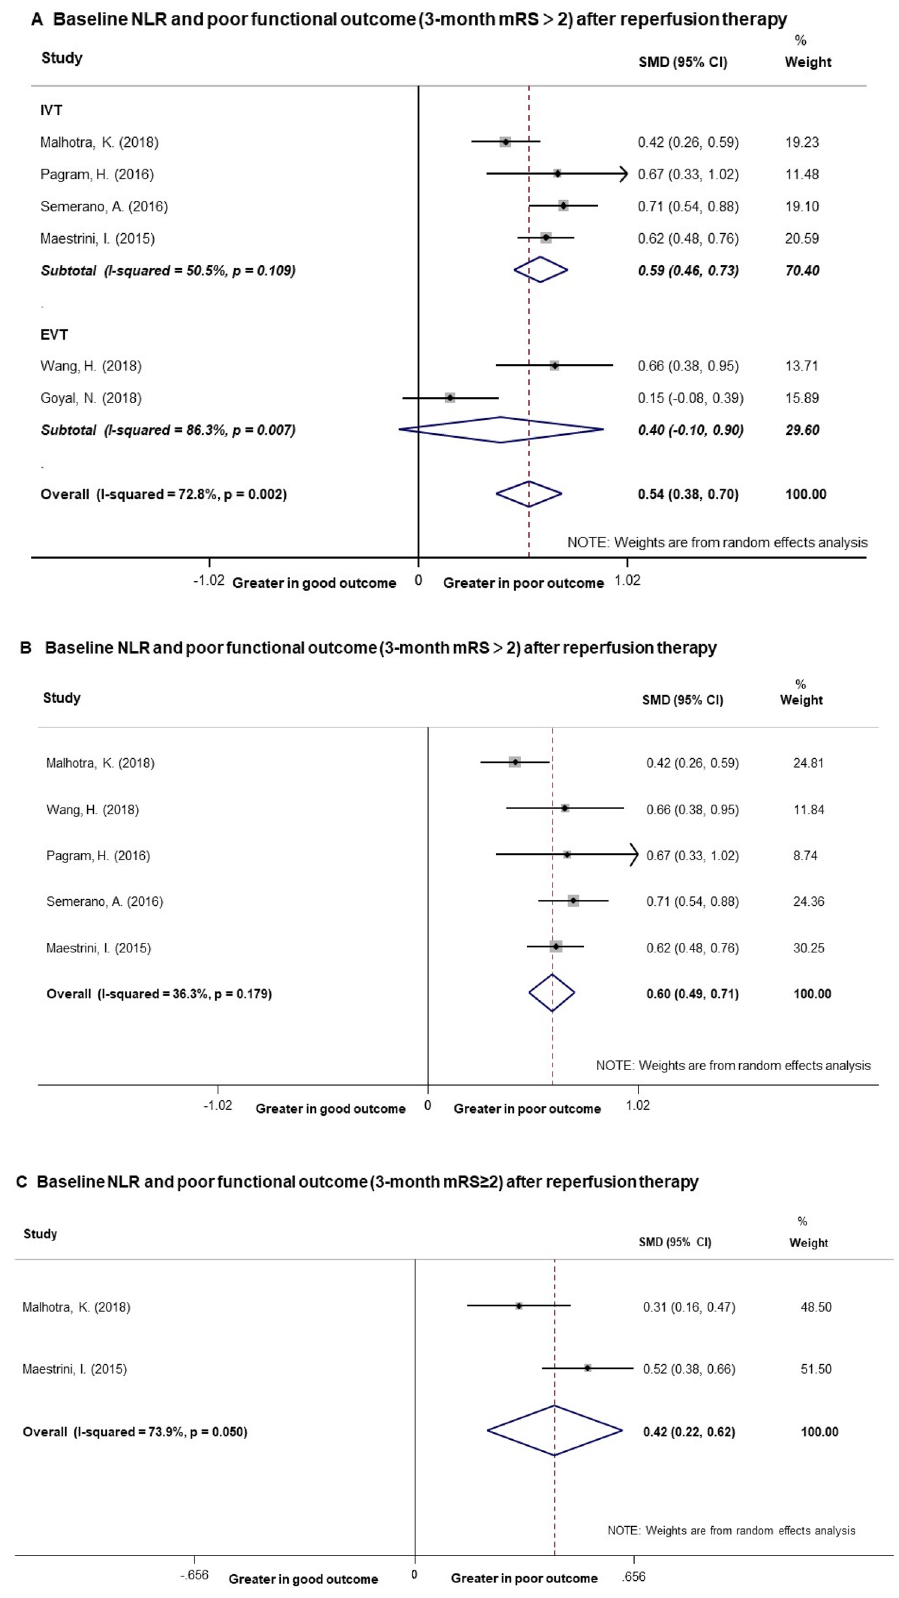
Figure 2. Forest plots of baseline NLR level and poor functional outcome at 3 months. ( A ) Pooled analysis of poor functional outcome (defined as mRS > 2) at 3 months after reperfusion therapy. ( B ) Pooled analysis of poor functional outcome (defined as mRS > 2) at 3 months after reperfusion therapy after excluding one study which brought high heterogeneity. ( C ) Pooled analysis of poor functional outcome (defined as mRS ≥ 2) at 3 months after reperfusion therapy in AIS patients. NLR Neutrophil to lymphocyte ratio, mRS modified Rankin